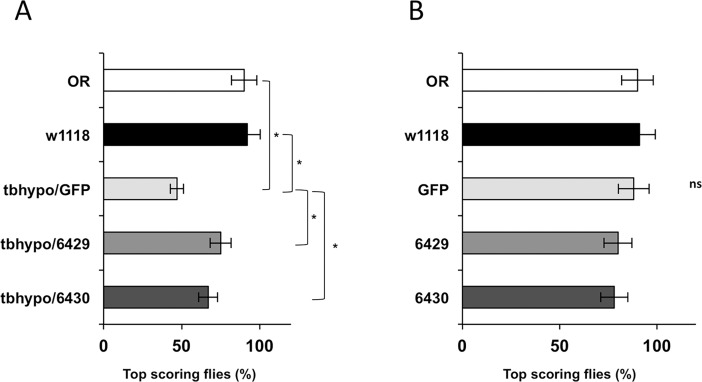
Genetic interaction between tbph and RhoGAPp190.A) The climbing ability of tbph-hypomorphic allele flies is partially rescued in flies silenced for RhoGAPp190 (tbhypo/6429: tbphΔ23,elav-GAL4/UAS-RhoGAPp190-RNAi;UAS-Dcr2,UAS-tbph-RNAi/+) and (tbhypo/6430: tbphΔ23,elav-GAL4/+;UAS-Dcr2,UAS-tbph-RNAi/UAS-RhoGAPp190-RNAi) flies with respect to the animals expressing an unrelated protein (tbhypo/GFP: tbphΔ23,elav-GAL4/+;UAS-Dcr2,UAS-tbph-RNAi/UAS-GFP). The assay was performed on 4 day-old adult animals. B) Effect of single RNAi overexpression in a wild type background (the behavior of w1118 and OregonR flies was overlapping). The observed variations were not statistically significant (ns). w1118 = white 1118. OR = OregonR. (GFP = elav-GAL4/+;UAS-GFP/UAS-Dcr-2). (6429 = elav-GAL4/RhoGAPp190 RNAi; UAS-Dcr-2/+). (6430 = elav-GAL4/+; RhoGAPp190 RNAi/Dcr-2). 100 flies for each genotype were tested. *p<0.05 (t-test), error bars indicate SEM.